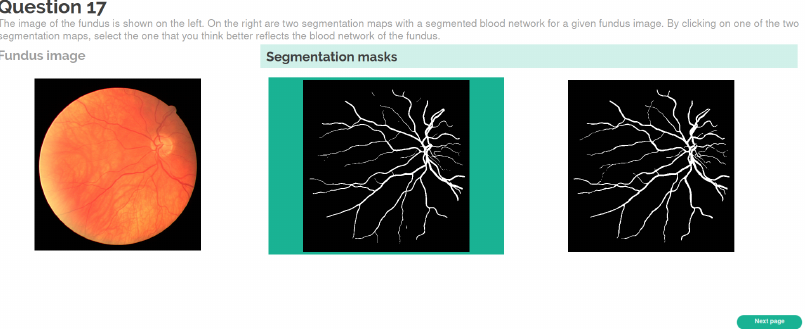
Figure A2. A representative page of the survey used in the second experiment with examples of the selected